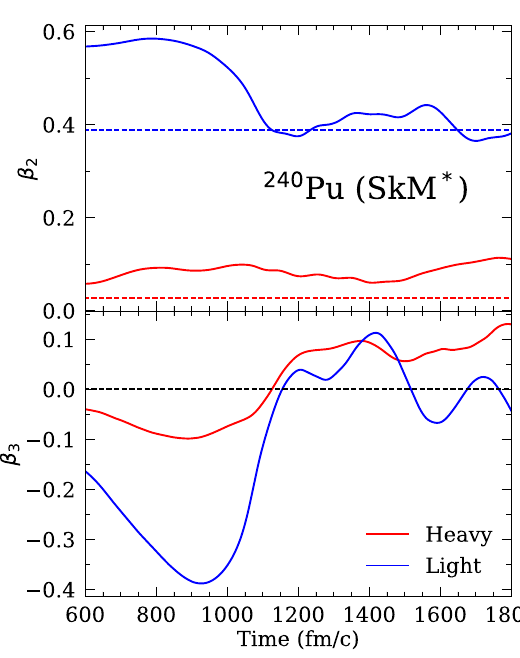
Figure 3. Evolution of β 2 and β 3 deformations of the nascent